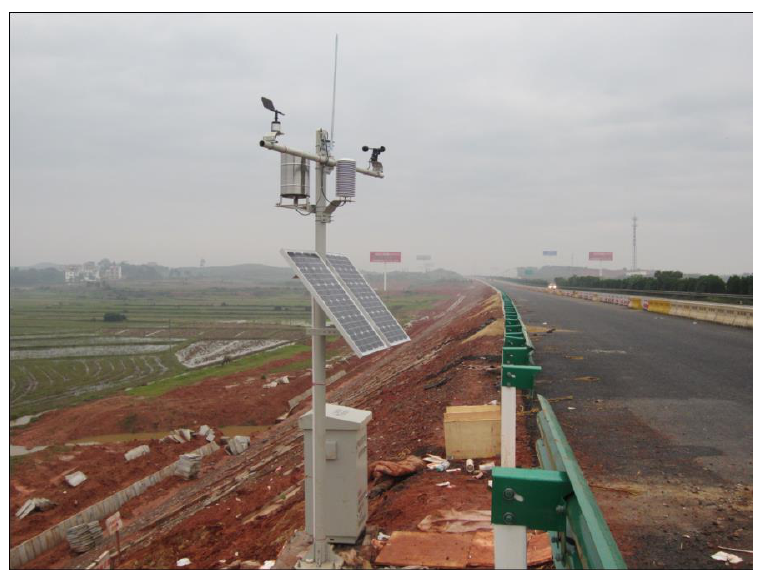
Figure 4. Small weather station (site picture).